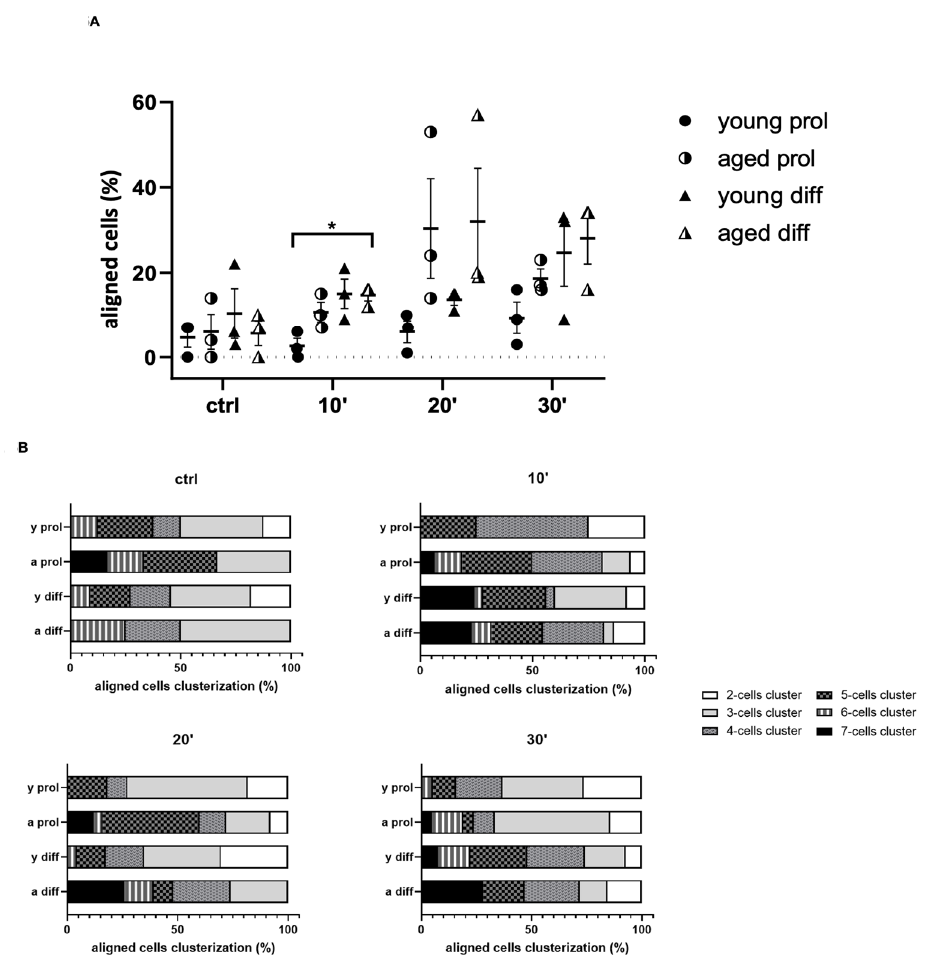
Figure 5. Effect of ViSS treatment on SC/myoblast alignment. ( A ) Percentages of aligned cells and ( B ) aligned cell clusterization. Data are expressed as mean ± SEM of three independent experiments ( n = 3). Aligned cells were scored out of a total of 120–240 cells for each experimental group. Significance was determined with two-way ANOVA test, followed by Tukey’s multiple comparisons test (simple effects within rows). * p ≤ 0.05.